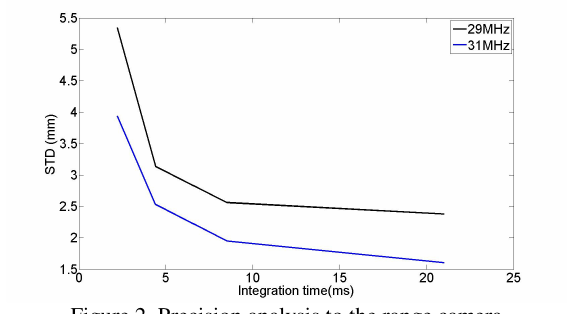
Figure 4. Amplitude and phase differences between true and biased